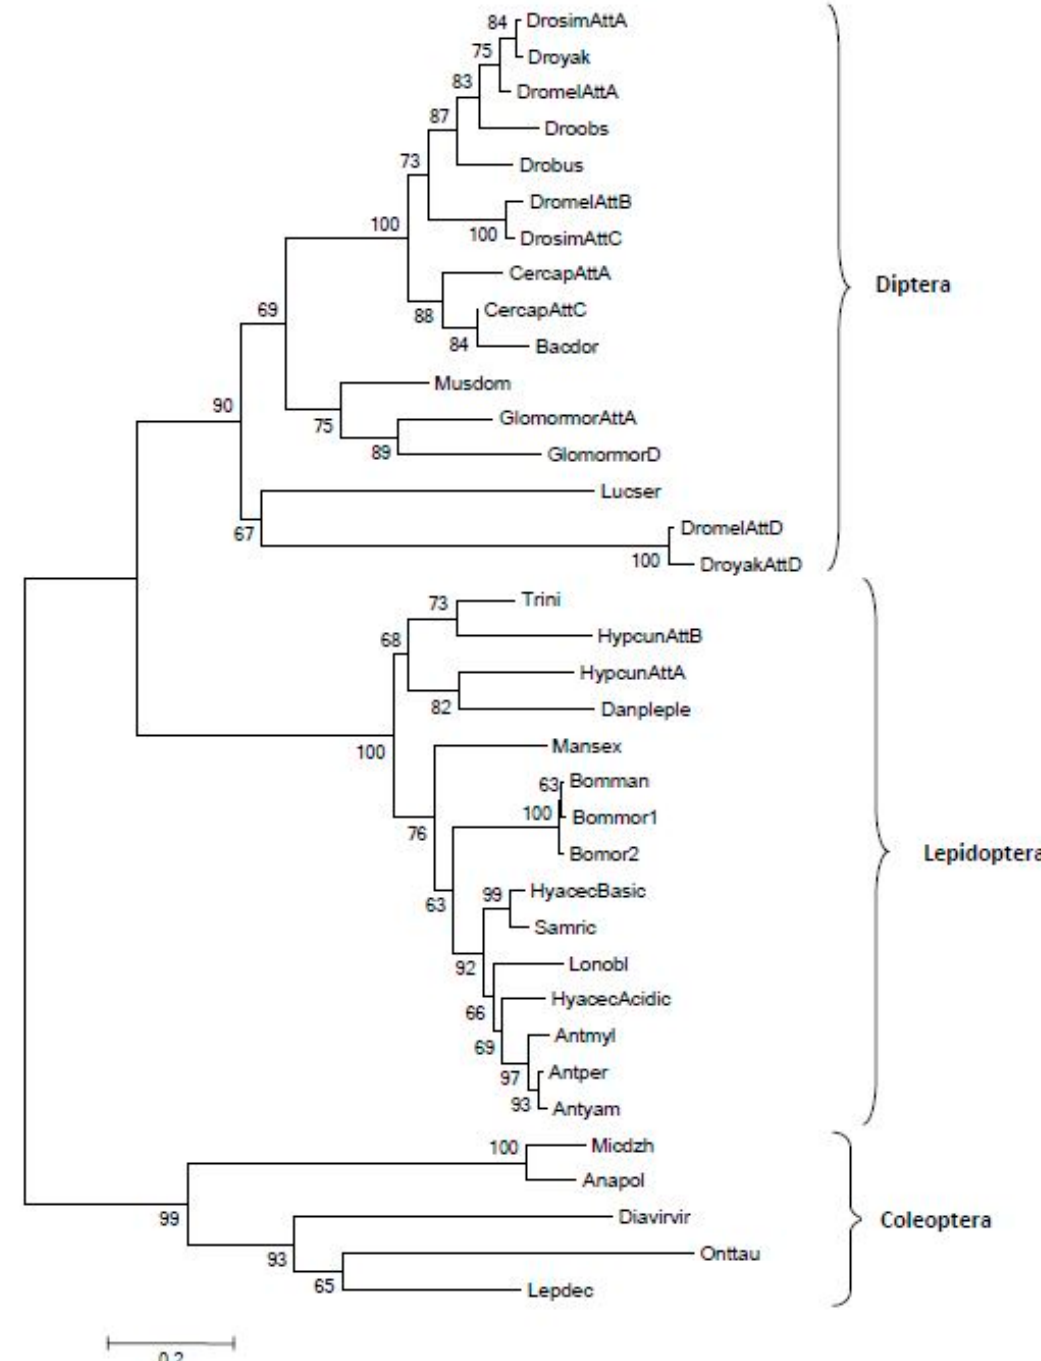
Figure 2. Phylogenetic tree of attacins from different insect orders obtained using the MEGA 6.0 program. The percentage of replicate trees in which the associated taxa clustered together in the bootstrap test (10.000 replicates) is shown next to the branches. The number 0.2 represents the genetic distance. Accession numbers: Drosophila simulans Attacin A EDX07123; Drosophila yakuba EDW91058; Drosophila melanogaster Attacin A Z46893; Drosophila obscura XP_022225780; Drosophila busckii